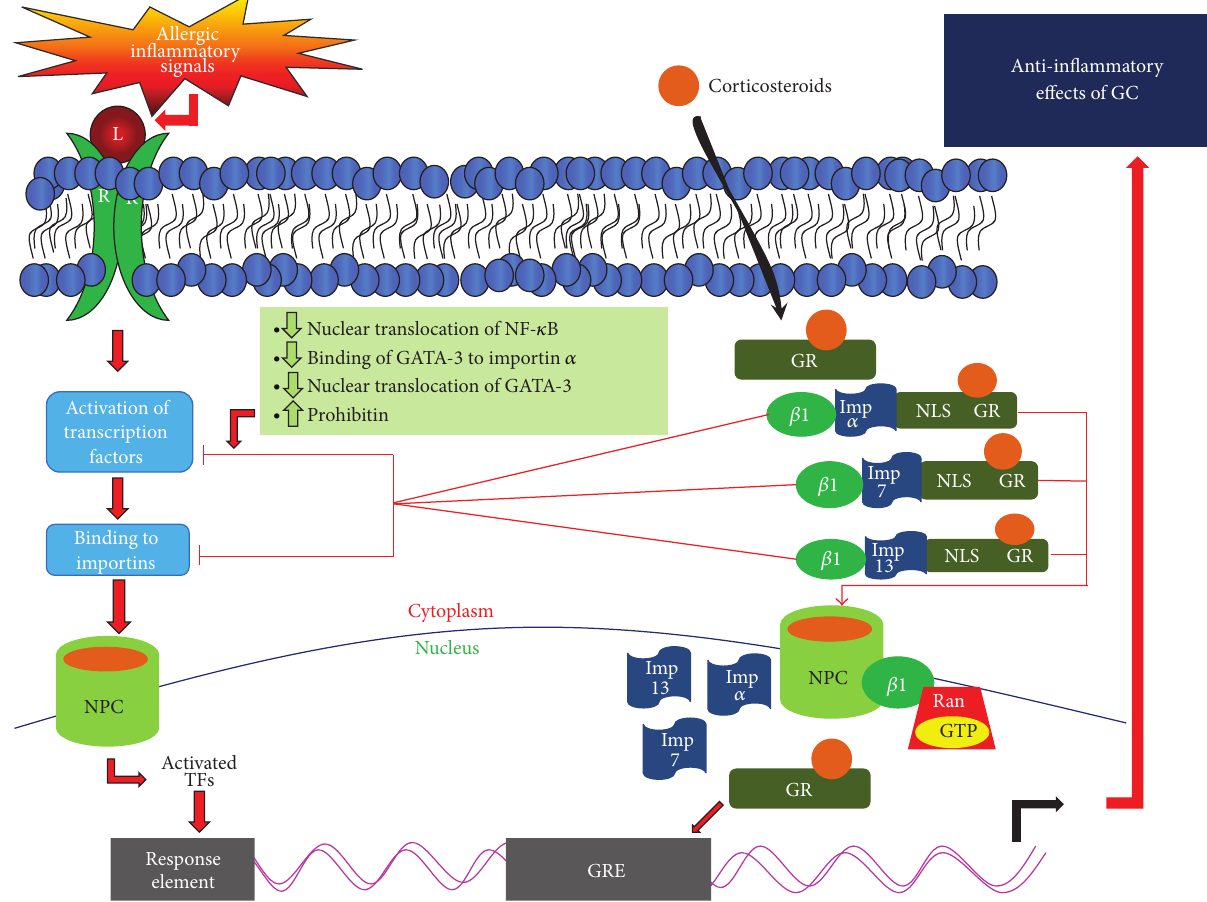
Figure 4: Activation of glucocorticoid receptor (GR) and control of allergic inflammation:corticosteroids are lipophilic in nature and cross the bilipid membrane to bind to their receptors in the cytoplasm. The nuclear localization signal (NLS) on steroid-receptor complex can be recognized by importin 𝛼 , importin 7, or importin 13 to transport the steroid-receptor complex to the nucleus to bind to glucocorticoid- response element (GRE) to induce the transcription of several genes that elicit anti-inflammatory effect. Also, the steroid-receptor complex in the cytoplasm can also induce effects on the nuclear transport of activated transcription factors by either inhibiting the binding of activated transcription factors to importins or increasing the inhibitory molecules, such as prohibitin, in the cytoplasm.